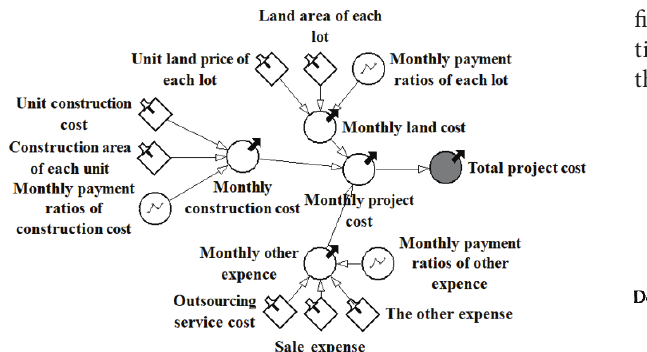
Figure 8. Cost model Figure 9. Financial cost and income